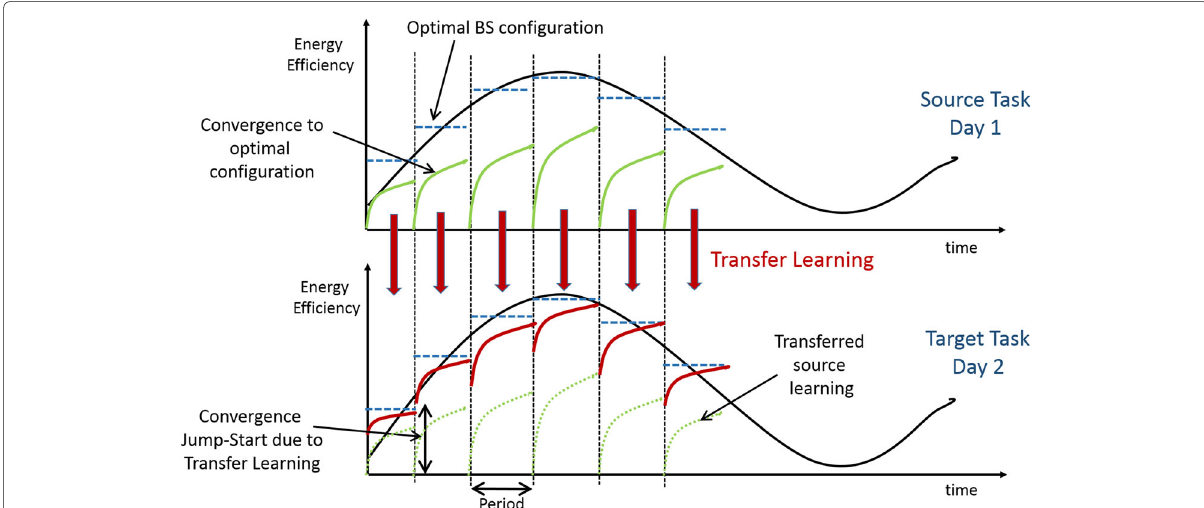
Fig. 3 Transfer learning for Transfer EEM-UCB (TLEEM-UCB) policy. The figure illustrates the principle of transfer learning between two consecutive days on the learning convergence